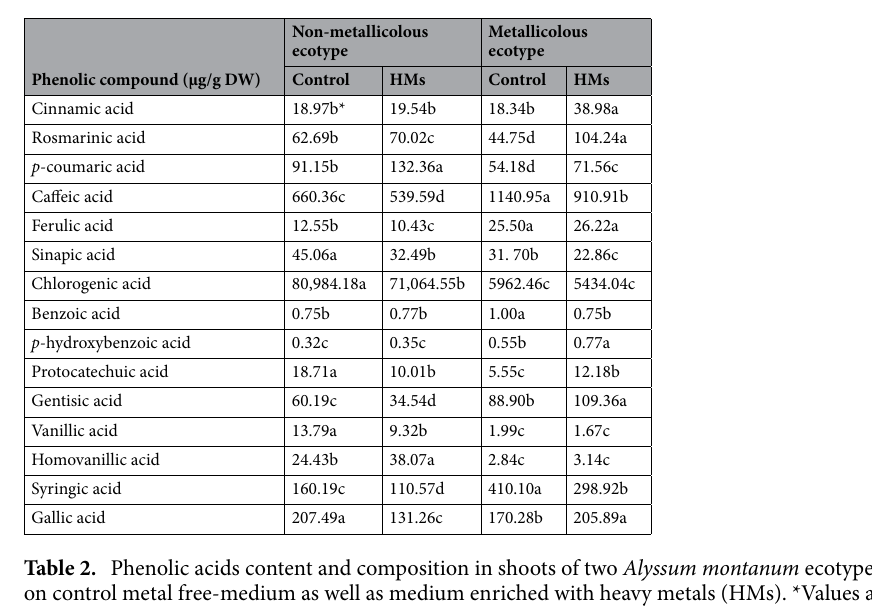
Phenolic compound (μg/g